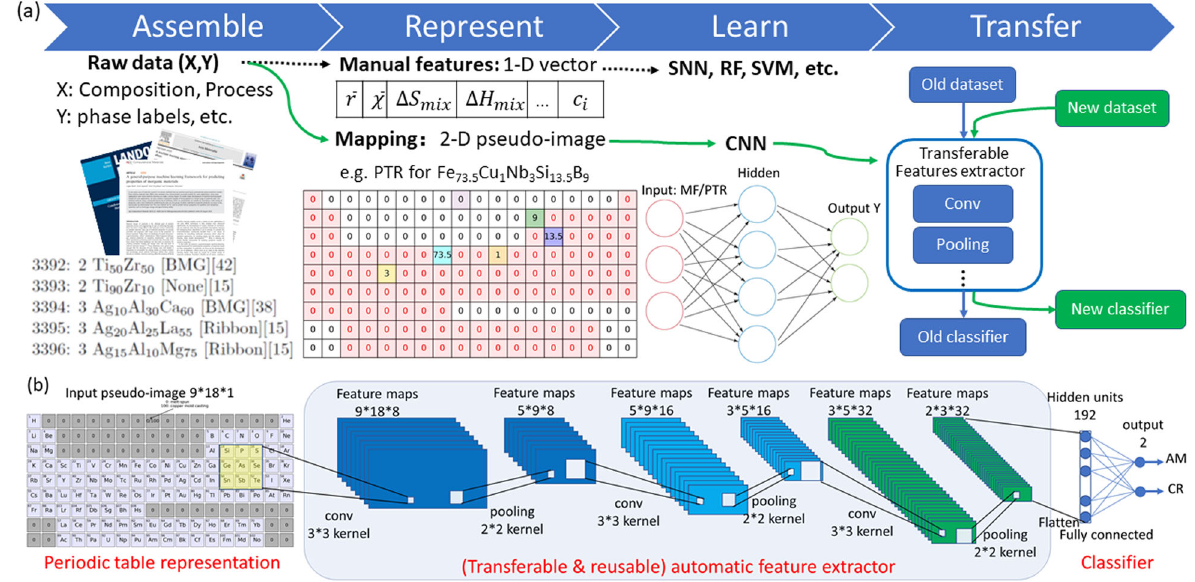
Fig. 1 The work fl ow of our works. a The work fl ow of the proposed GTDL framework (in green solid arrows) and conventional machine learning (in black dotted arrows) which does not have the ability of automatically extracting features and knowledge transfer. The schematics for assembling dataset, data representation, machine learning, knowledge transfer, and an example of PTR (periodic table representation) were given. MF, SNN, RF, SVM, and CNN denotes manual features, shallow neural network, random forest, supported vector machine, and convolutional neural network, respectively. In GTDL framework, raw data are mapped to 2-D pseudo-images fi rst, features are then extracted automatically by convolutional layers, knowledge is transferred by sharing the well-trained feature extractors for new tasks with small dataset. b The schematics for our VGG-like convolutional neural